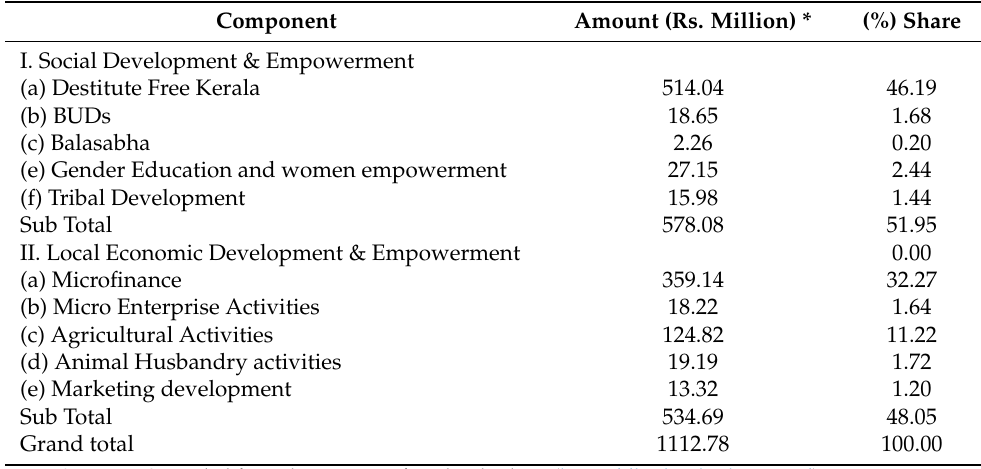
Table 3. Key components of Kudumbashree programme—Financial achievement,